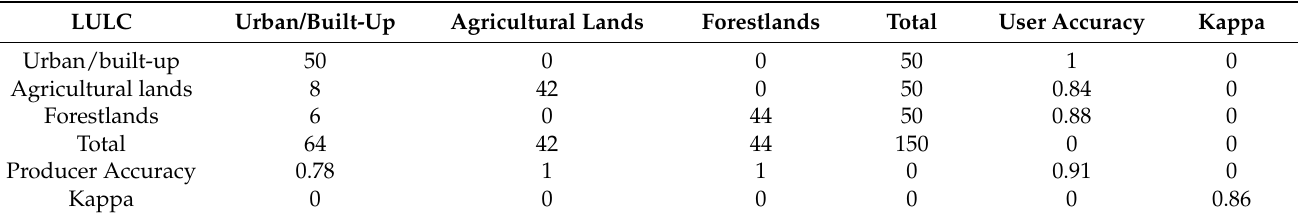
Table A1. User, Producer and Kappa statistics for the classified image of 1986.